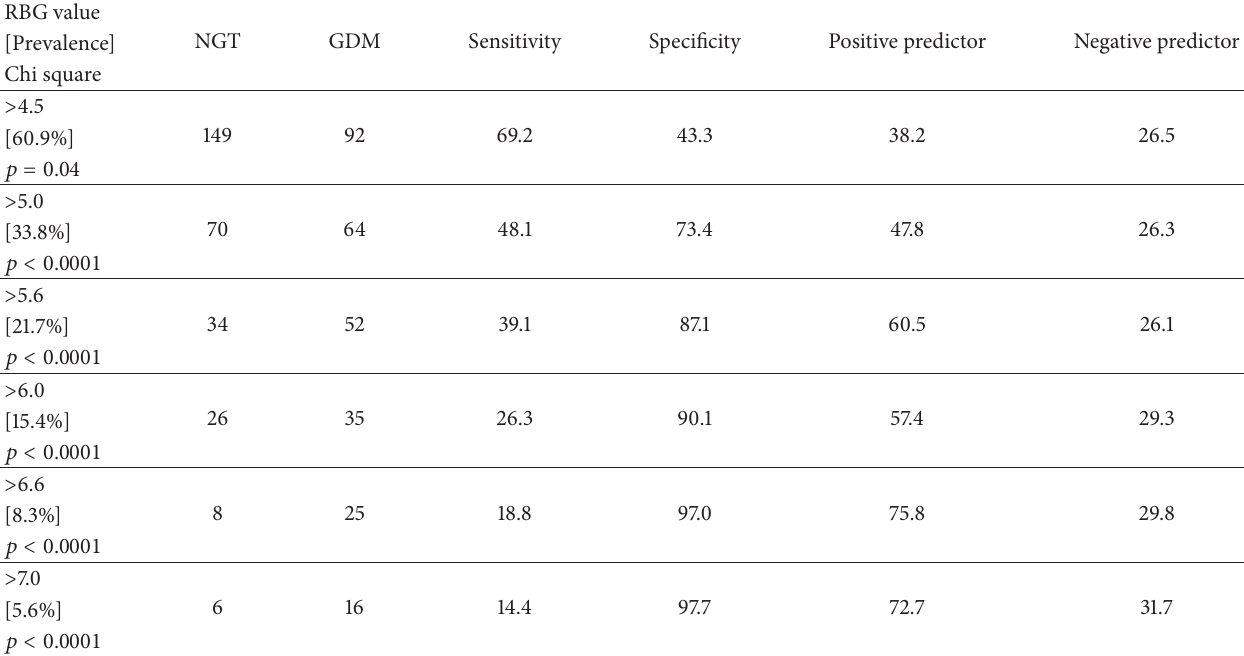
Table 2: Comparison between RBG values at booking and the carbohydrate metabolic status along with the sensitivity, specificity, positive predictor, and negative predictor values at each RBG range.